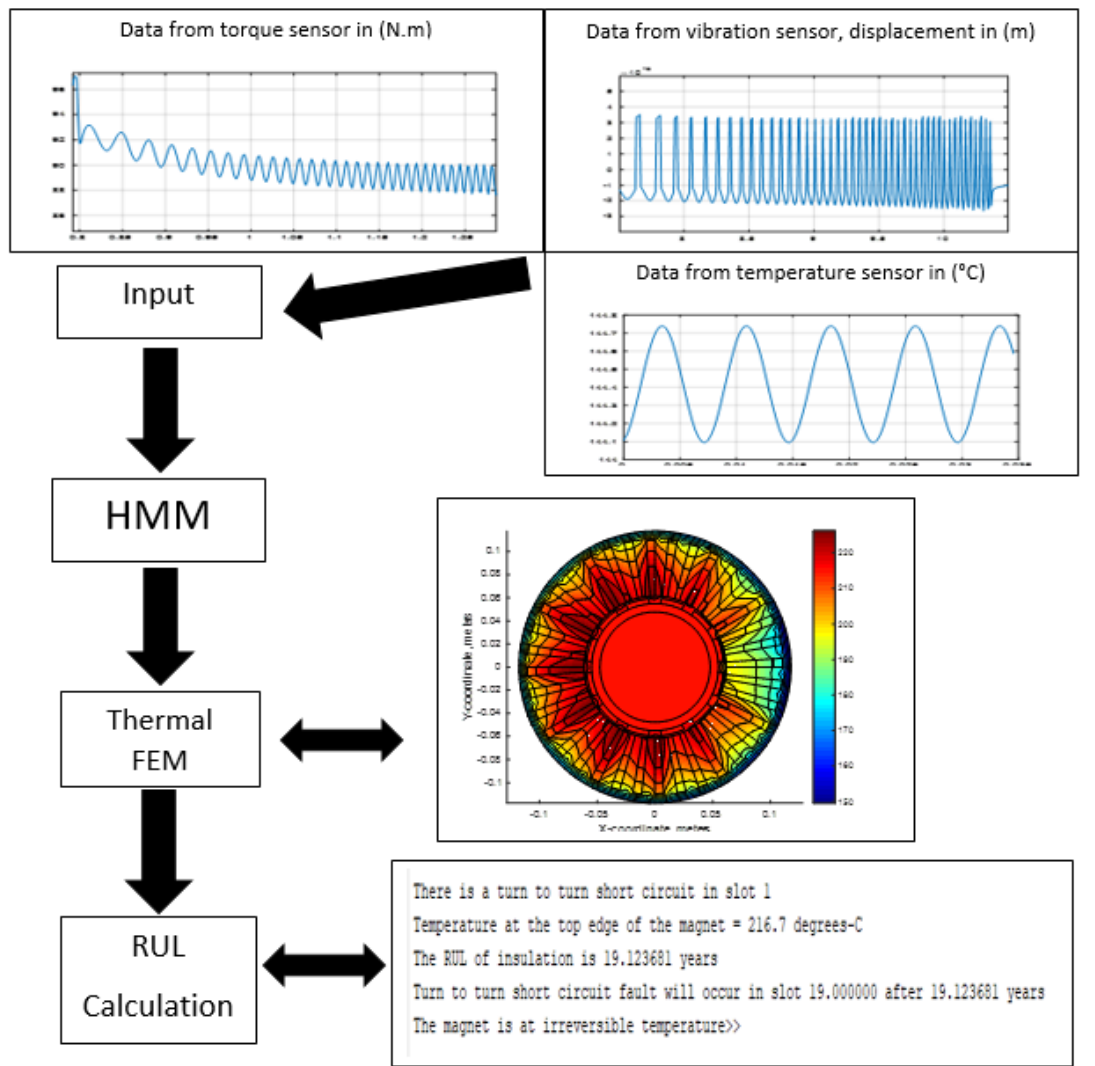
Figure 27. Illustrative example for the RUL calculation in the case of turn to turn short circuit.